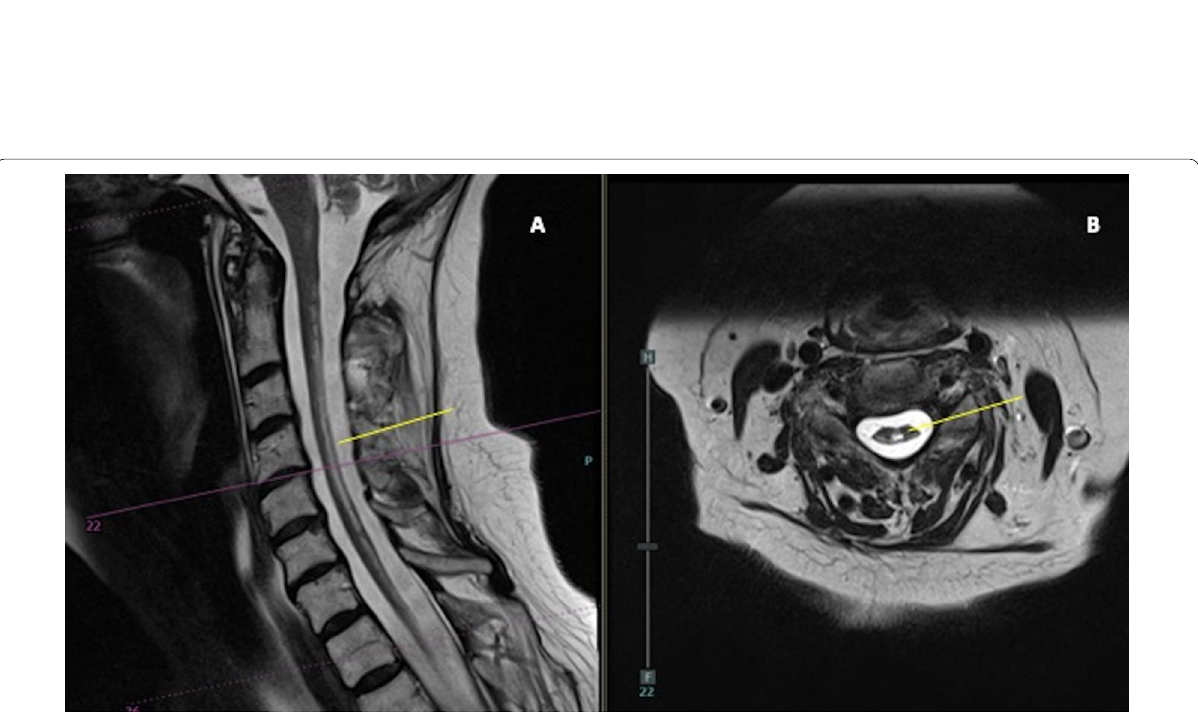
Fig. 3 MRI sagittal T2 image ( A ) of the cervical spine demonstrates longitudinally extensive T2 hyperintense cord lesions (yellow arrow), with corresponding foci that are as bright or brighter than CSF on the axial images ( B ) (yellow